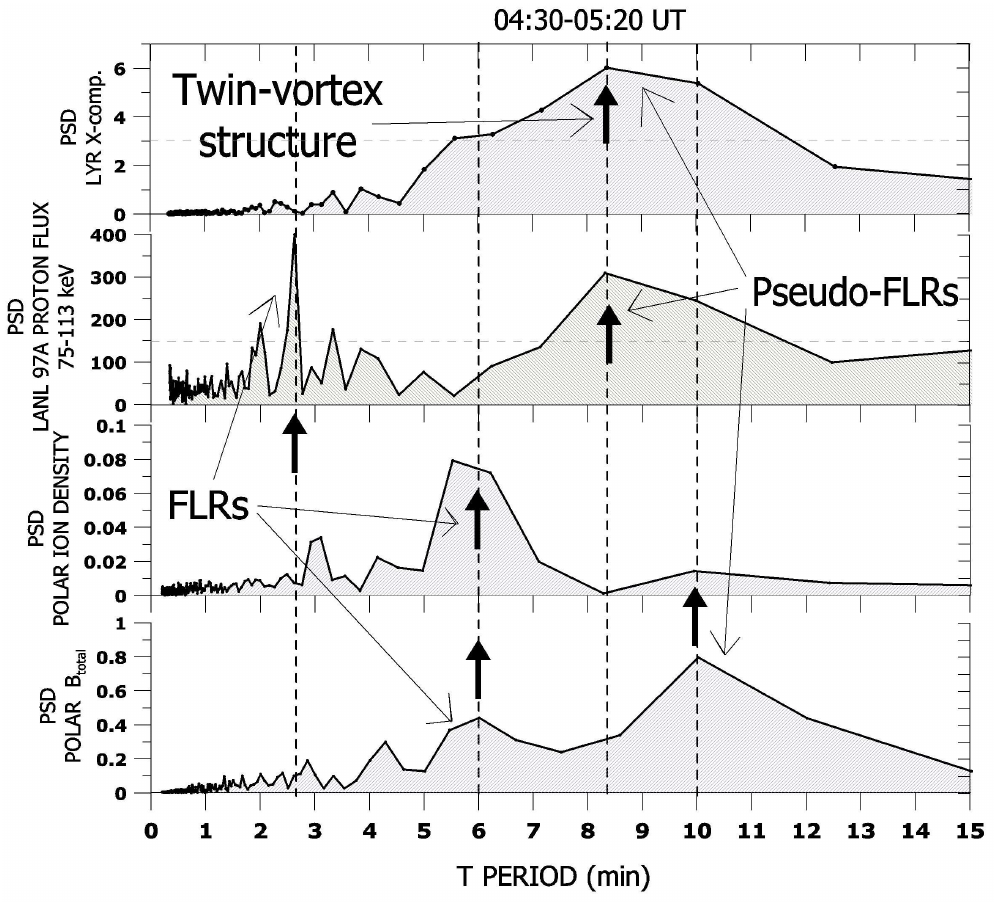
Fig. 9. Power spectral densities (PSDs) of the interval 04:30-05:20 UT for (a) the X-component magnetogram of LYR, (b) the 75–113keV proton differential fluxes of LANL 97A, (c) the POLAR ion density, and (d) the POLAR magnetic field magnitude. The almost monochro- matic lines of T=2.5 and 6min correspond to FLRs, whereas the broad-band response of LYR is associated with the detected twin vortex ionosphere structures, which are produced by the solar wind pressure